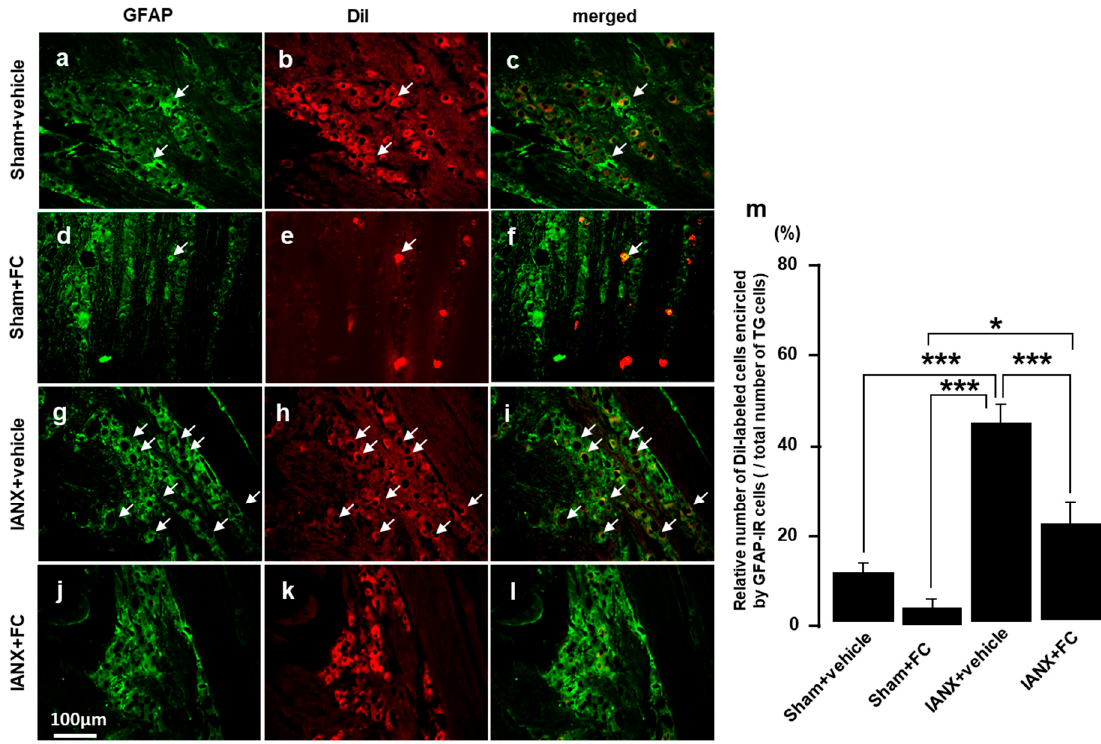
Figure 8. The effect of FC injection into TG on GFAP expression in TG in sham and IANX rats. ( a – c ): sham + vehicle, ( d – f ): sham + FC, ( g – i ): IANX + vehicle, ( j – l ): IANX + FC rats. ( m ): Relative number of GFAP-IR cells in sham + vehicle, sham + FC, IANX + vehicle or IANX + FC. FC: aconitase inhibitor. The arrows indicate DiI-labeled cells encircled by GFAP-IR cells. * p < 0.05, *** p < 0.001. n = 5 in each group.